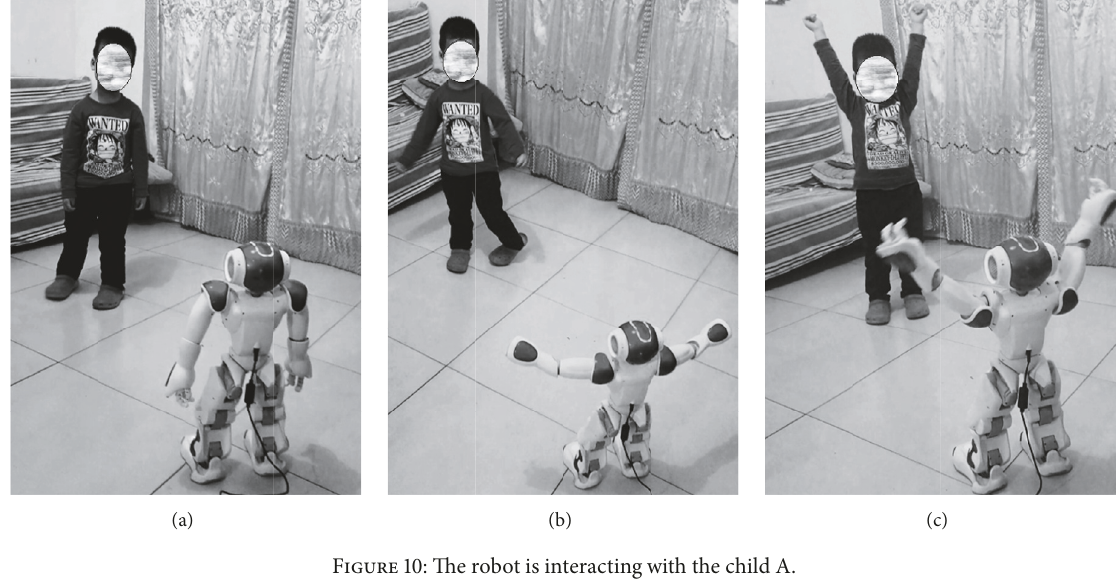
Figure 10: The robot is interacting with the child A.